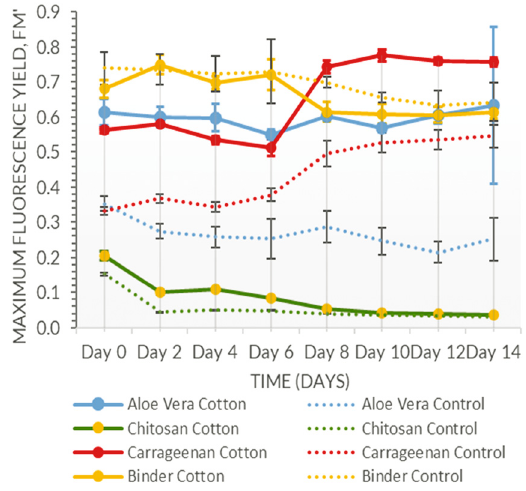
Figure 4: Closed incubation of 20% w/w binder on textiles: cotton ( mean StDev = 0.032 ) , canvas ( mean StDev = 0.030 ) , polyester ( mean StDev = 0.047 ) , hessian ( mean StDev = 0.047 ) , control ( mean StDev = 0.057 ) , and carrageenan samples: cotton ( mean StDev